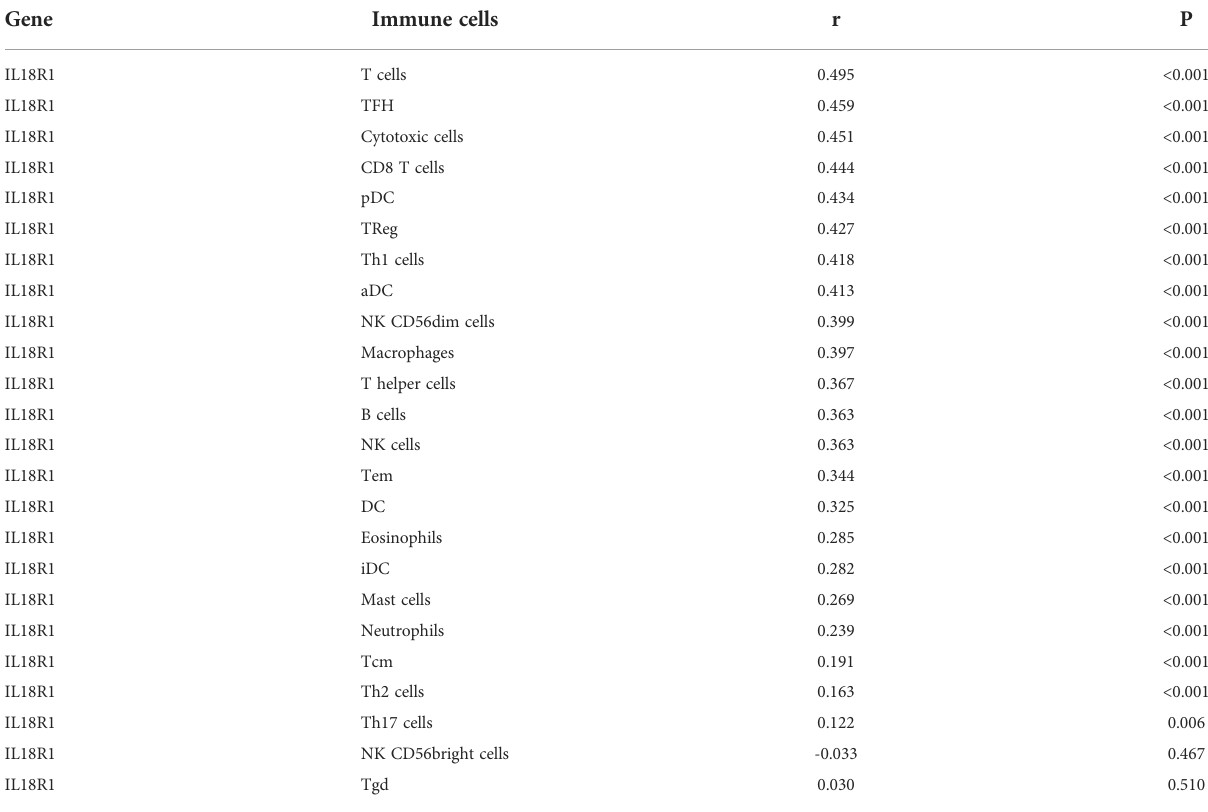
TABLE 5 IL18R1 was signi fi cantly associated with the levels of immune cells in LUSC.